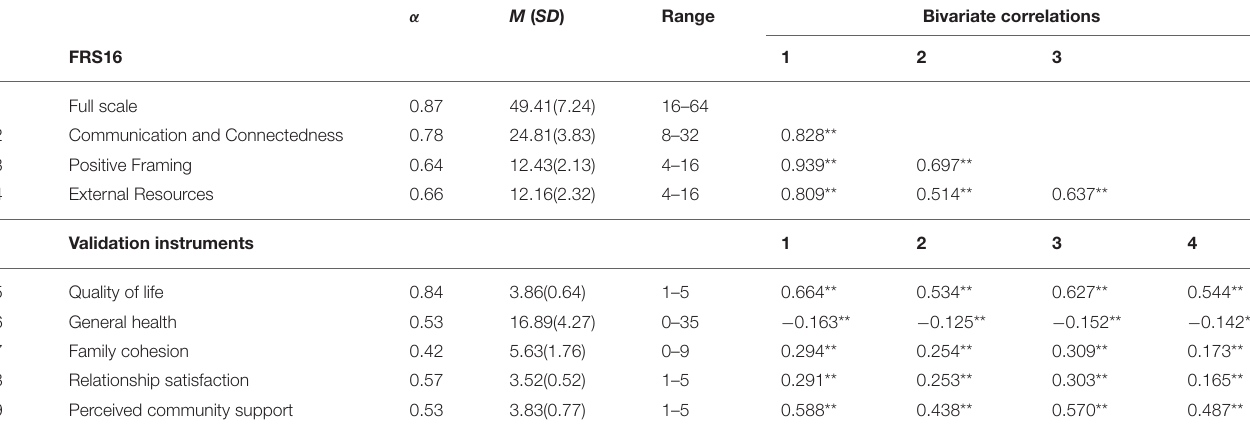
TABLE 2 | Descriptive statistics of main variables of US